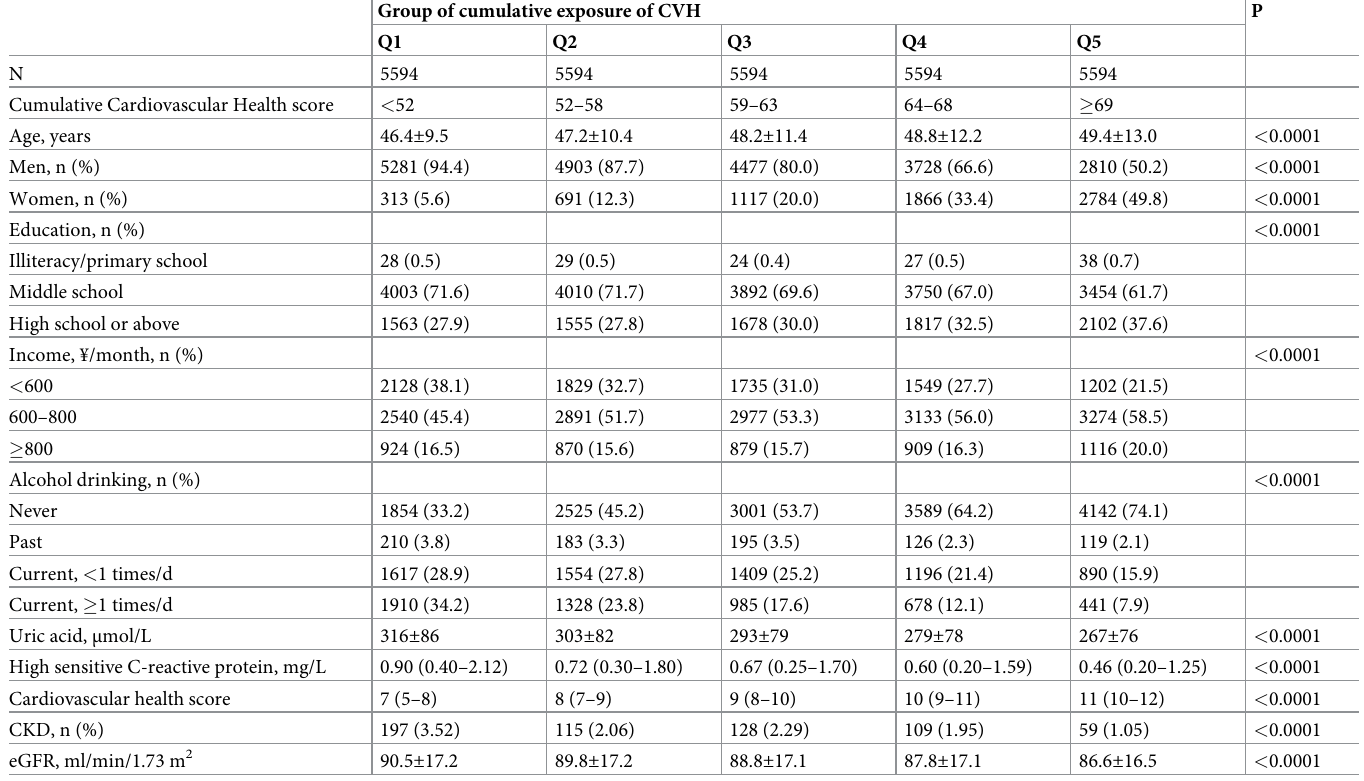
Table 1. Characteristic of the participants in 2006 according to the cumulative exposure of CVH. Group of cumulative exposure of